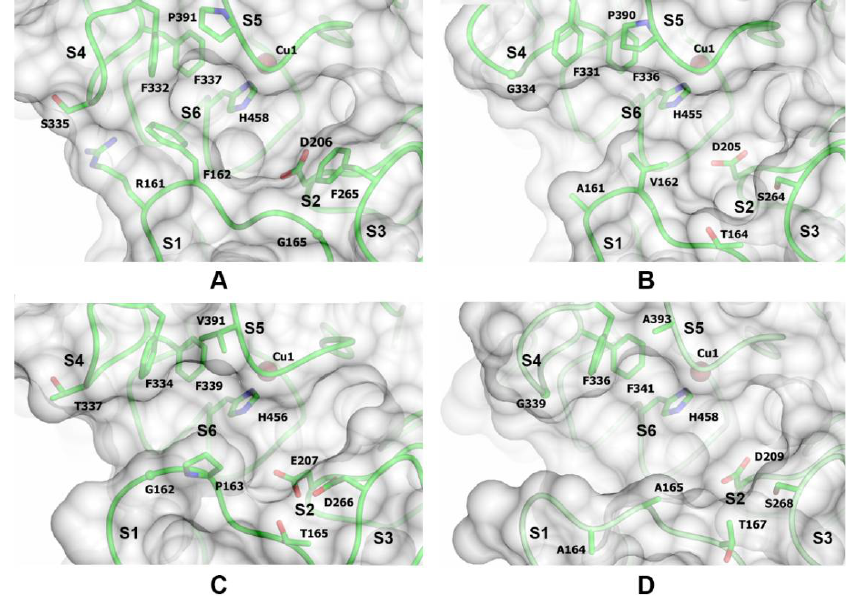
Figure 3. The substrate-binding pockets of ThL ( A ), CcL ( B ), AfL ( C ), and SmL ( D ). The positions